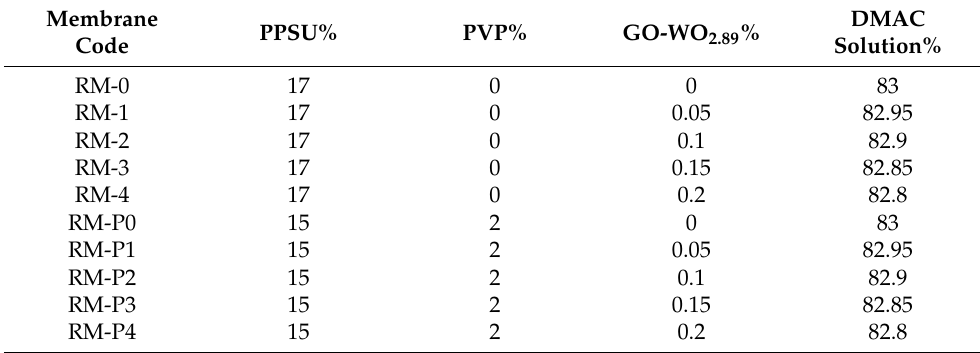
Table 1. Composition of polymer, additives, and solvent for membrane fabrication.